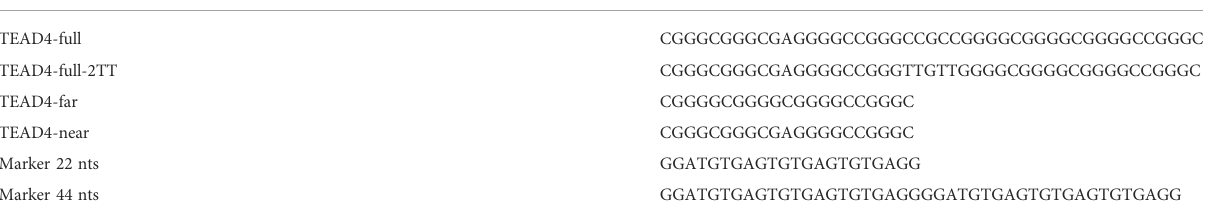
TABLE 1 DNA sequences herein